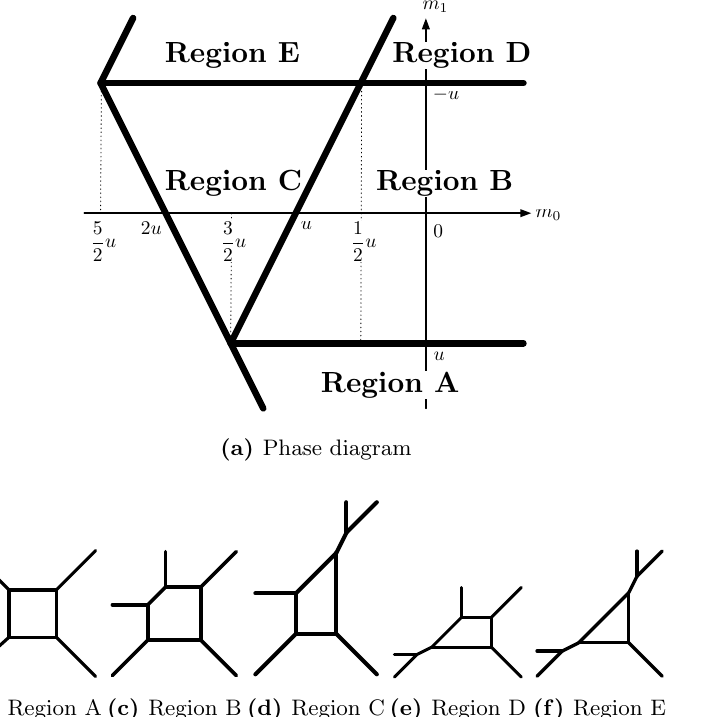
Figure 19. The phase diagram and the corresponding 5-brane web diagrams of the E 2 theory when we use a 5-brane web without an